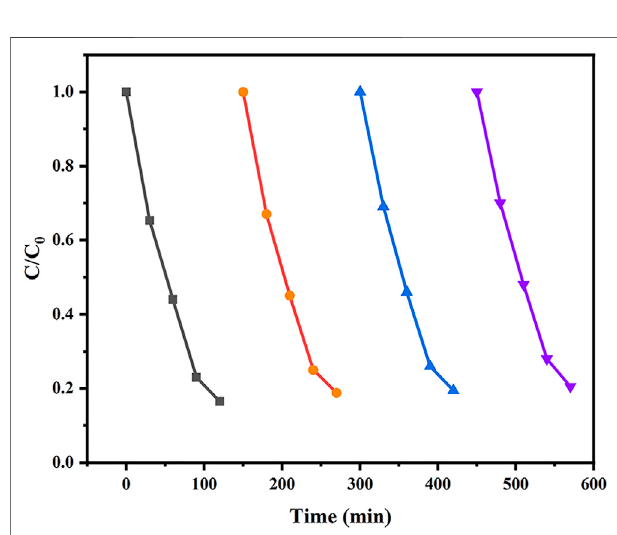
FIGURE 14 | The reusability test results of